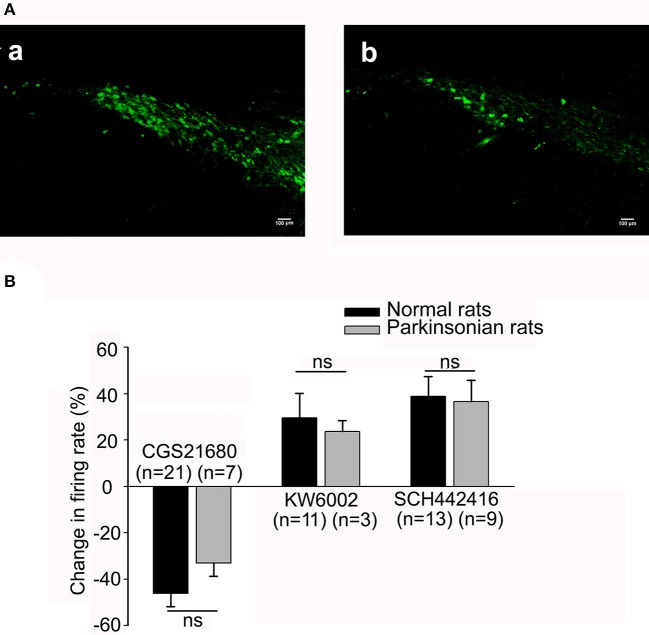
Comparison of the electrophysiological effects of adenosine A2A receptor agonist and antagonist in both normal and parkinsonian rats. (A) Confirmation of 6-OHDA hemi-parkinsonian rat model. Fluorescent images revealing tyrosine hydroxylase (TH) immunostaining in the substantia nigra pars compacta (SNc) of both normal (a) and 6-OHDA hemi-parkinsonian (b) rats. Scale bars = 100 μm. (B) Comparison of the effects of 1 μM CGS21680, 1 μM KW6002, and 1 μM SCH442416 on the spontaneous firing rate of pallidal neurons between normal (black bars) and 6-OHDA parkinsonian rats (gray bars). ns, not significant.